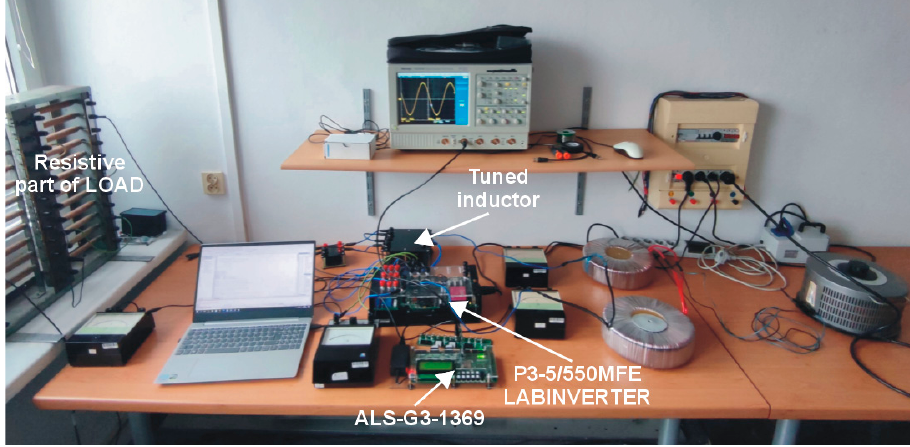
Figure 7. General view of the laboratory setup. Table 1. List of Basic Parameters of the ES Laboratory Model.